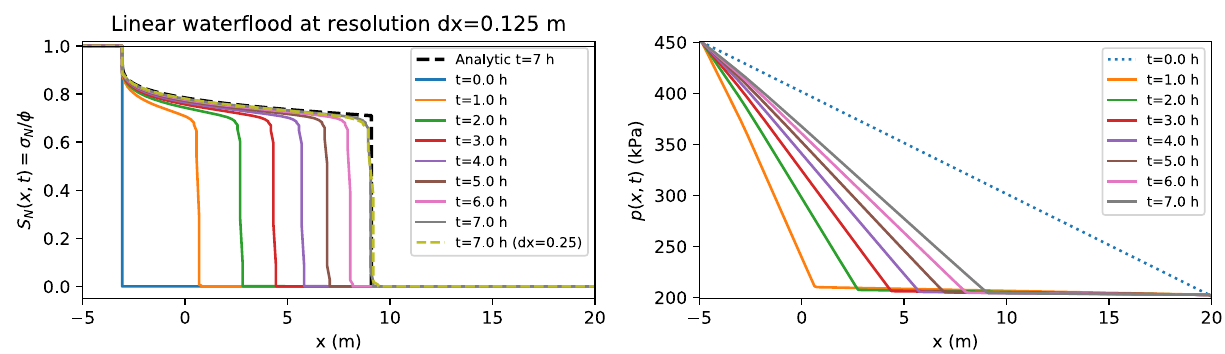
Figure 2. Comparison of NAPL saturation as a function of the distance from NAPL injection and the analytical solution 44 and numerical results from CactusHydro code for a two-phase nonaqueous-water flood.